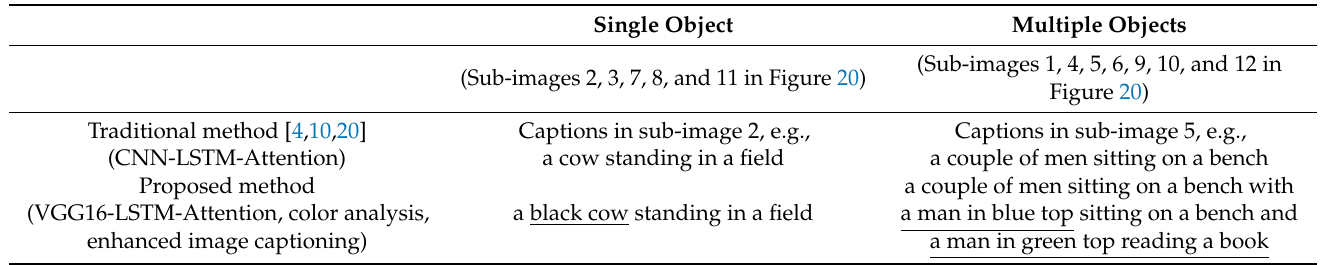
Table 4. Comparison between the traditional method and the proposed